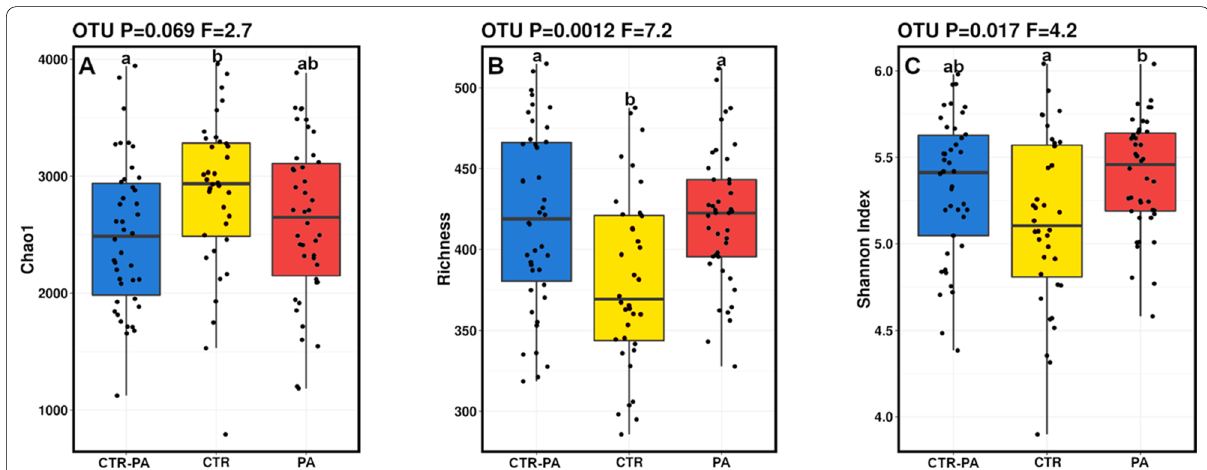
Fig. 5 Boxplots demonstrating the change at genus level in A Chao1, B Richness and C Shannon’s diversity for 35-day old piglets that were reared on sows fed different dietary treatments (CTR, CTR-PA and PA). Subscripts that differ denote a significant